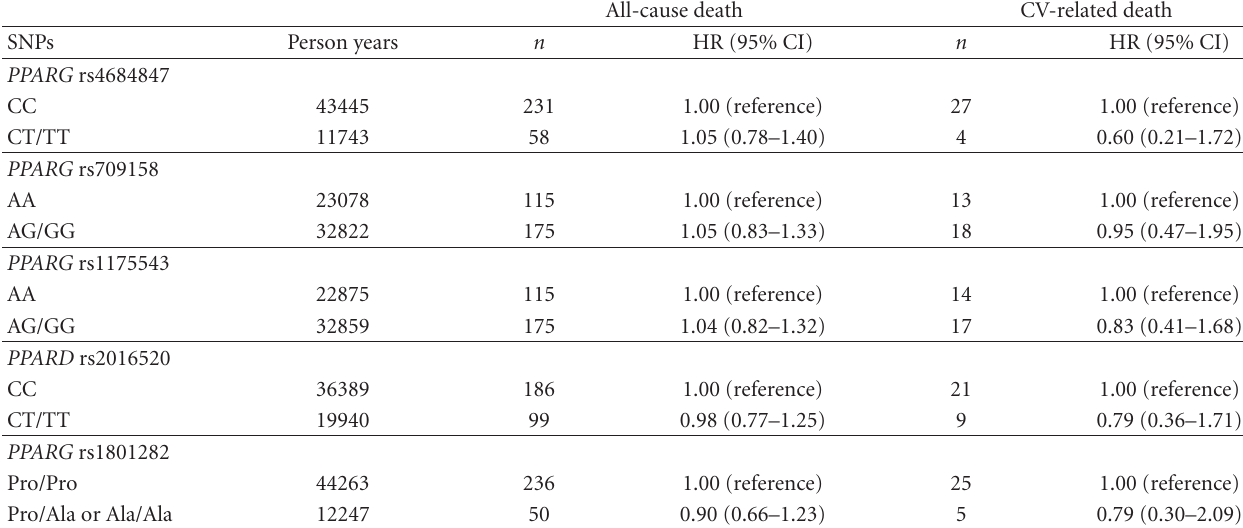
Table 4: Age-adjusted hazard ratios (HR) and 95% confidence intervals (95% CI) of premature (age < 65 years) all-cause and cardiovascular mortality for 5 PPAR SNPs. Person years: cumulative person years of follow